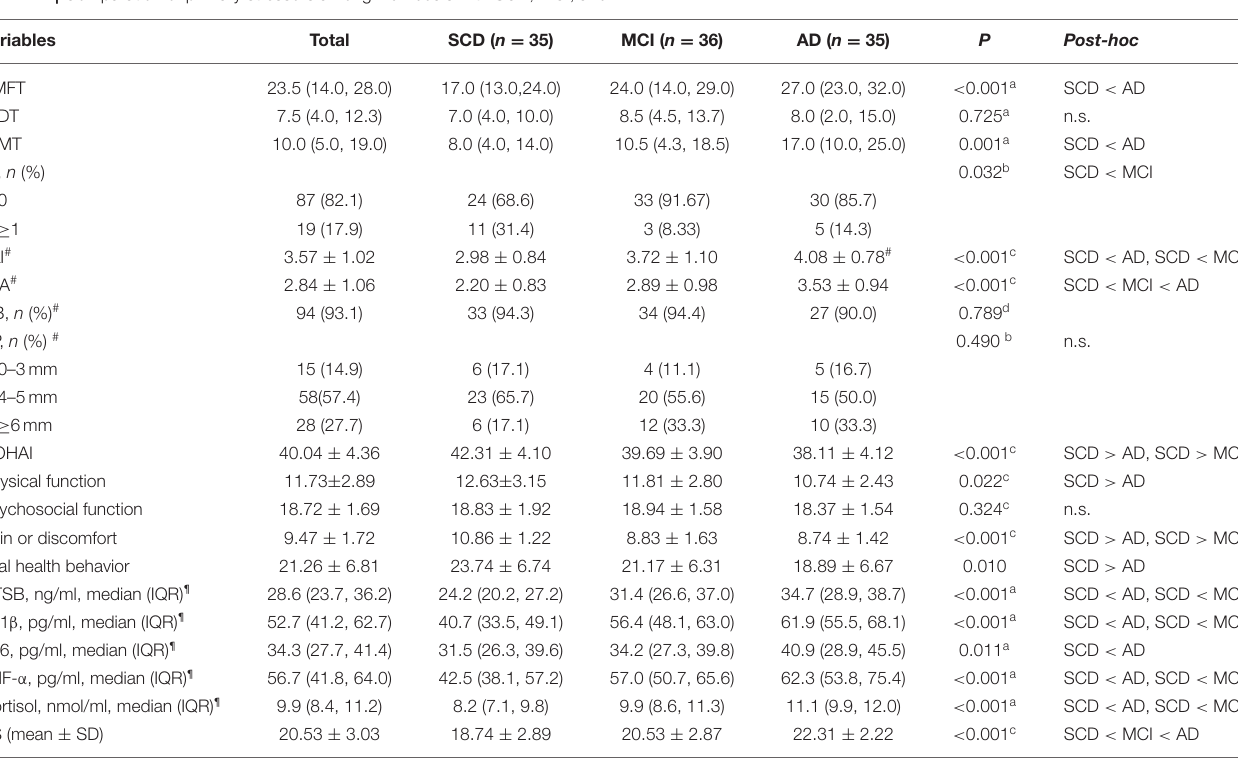
TABLE 2 | Comparation of primary stressors among individuals with SCD, MCI, and AD.